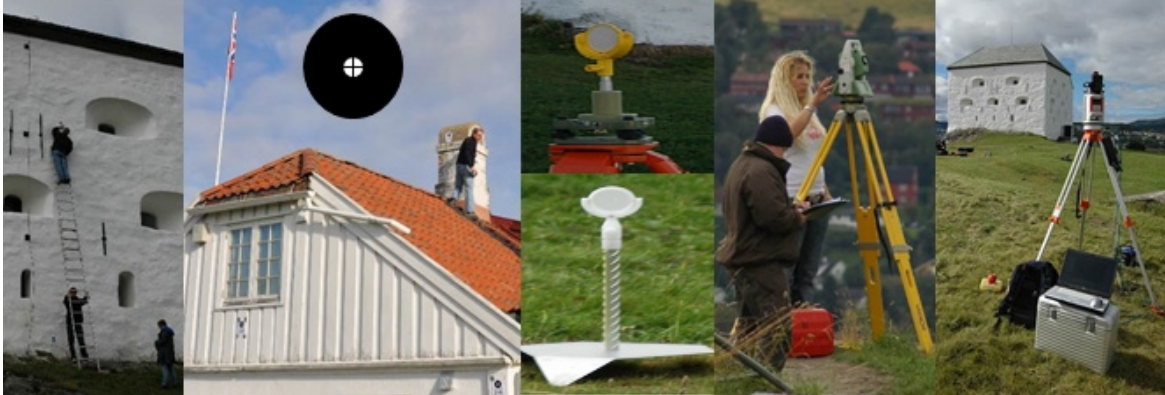
Figure 2: Control point signalisation at both fortress buildings, reflective targets for laser scanning, geodetic control point measurement and Riegl VZ-400 in use (f.l.t.r.)